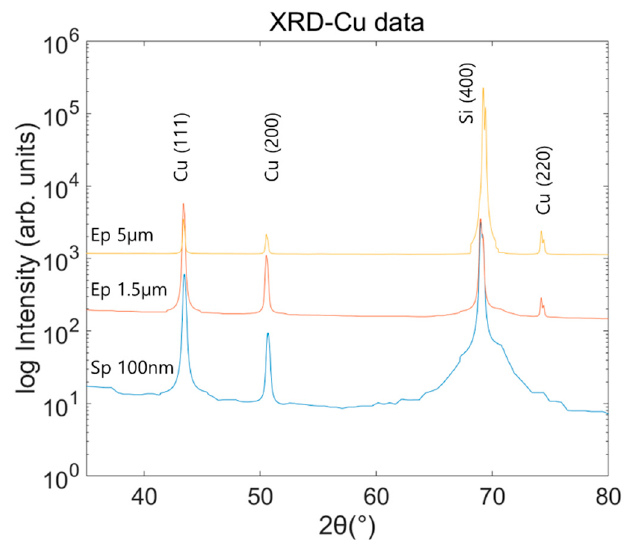
Figure 5. XRD analysis of the tested Cu films.